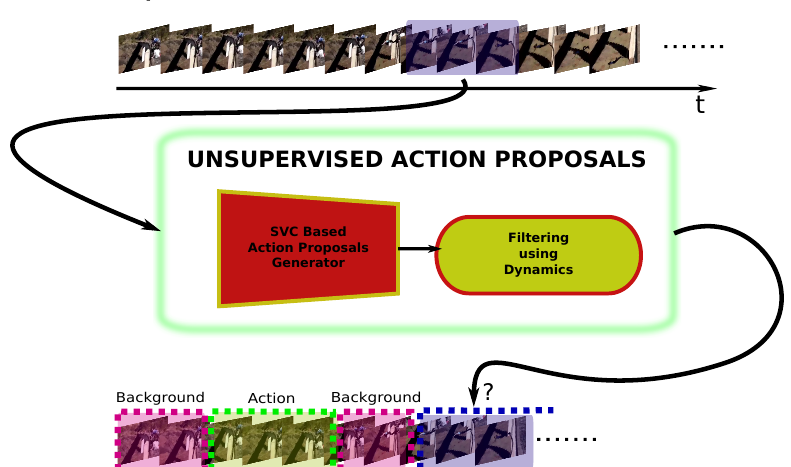
Figure 2. Overview of the unsupervised AP solution. It consists of an online SVC-based candidate action proposal generator, and a filtering mechanism over the dynamics of the features to consolidate the final action proposal segments. Only information until time t is available to the